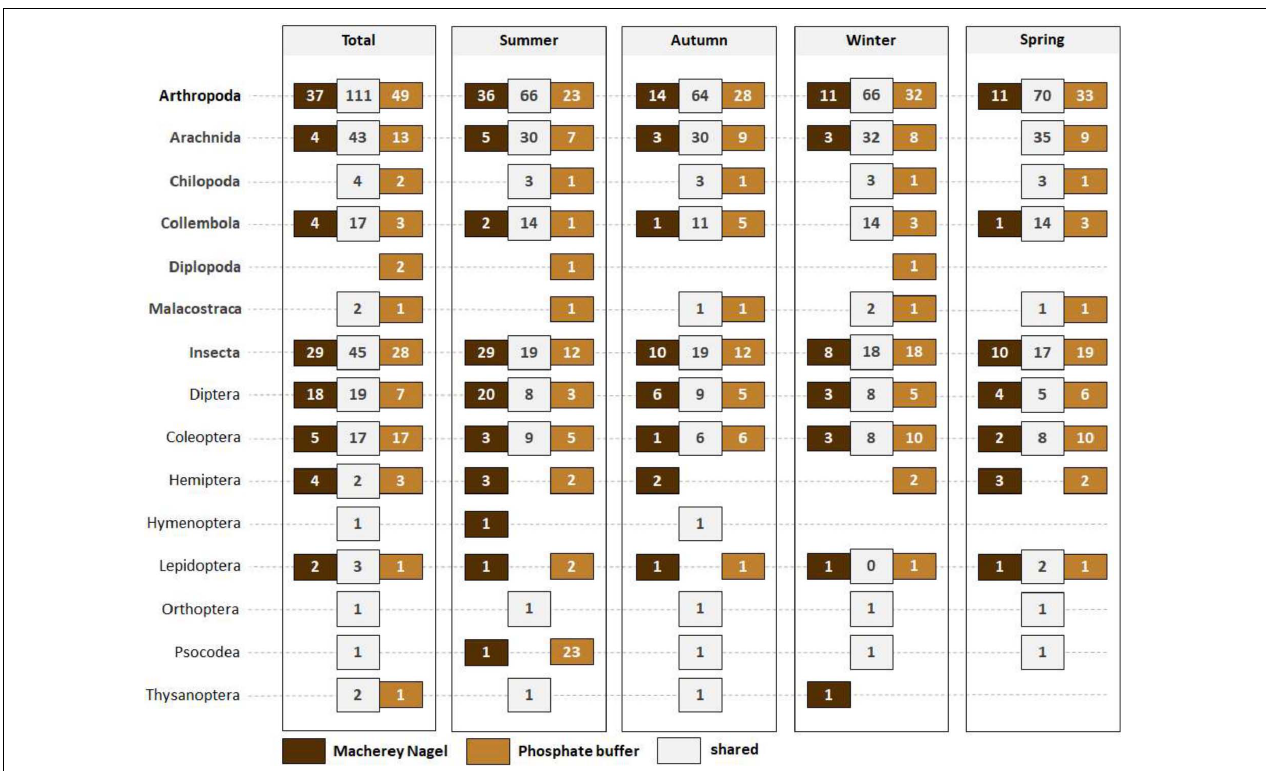
FIGURE 7 | Number of shared and unique arthropod species (blastID ≥ 99%) found between extraction methods for each season using both markers. The number of species per arthropod class and insect order recovered with either one or both of the two extraction methods is shown. Dark brown: OTUs from Macherey Nagel kit; Light brown: OTUs from phosphate buffer; White box: shared OTUs between Macherey Nagel kit and phosphate buffer.